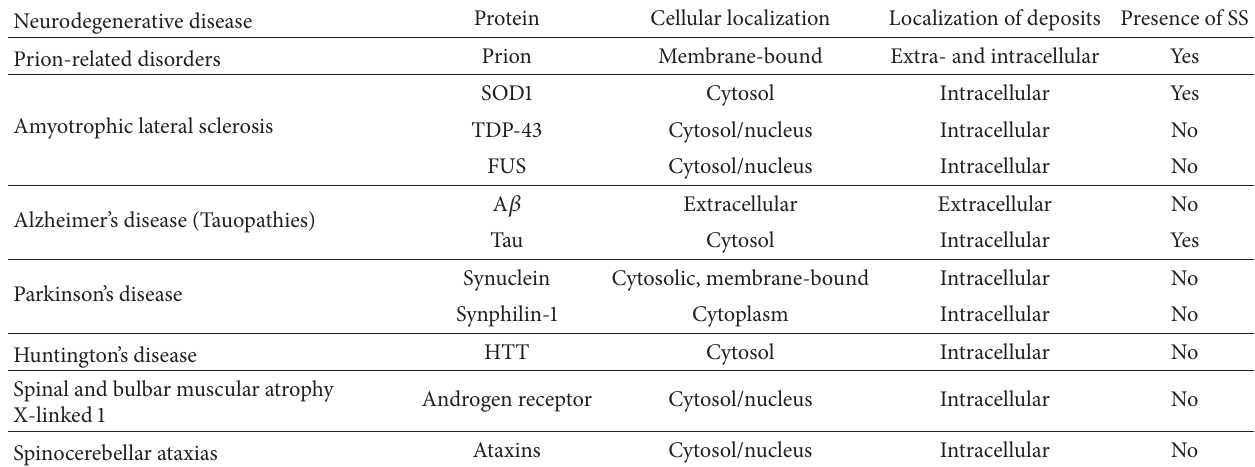
Table 1: Presence of disulfide bonds in proteins involved in neurodegenerative misfolding diseases.